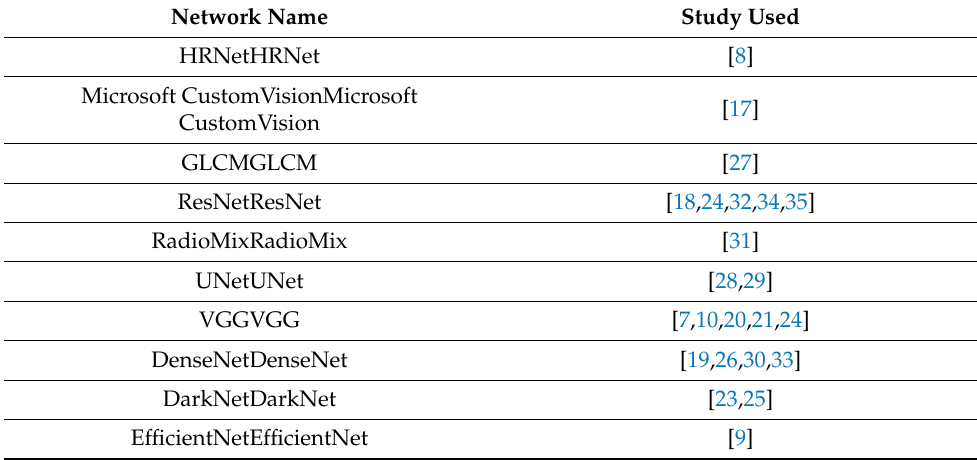
Table 6. Deep learning methods (CNN) used across all